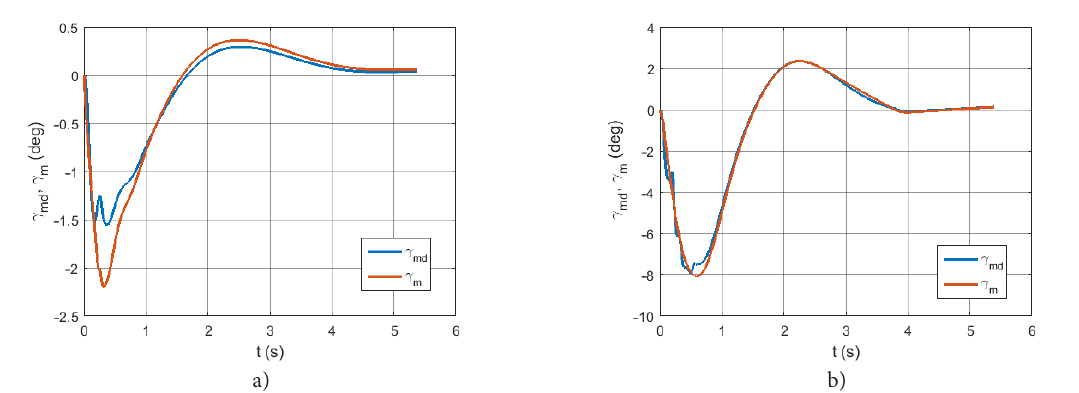
Figure 5. Actual m γ and desired md γ